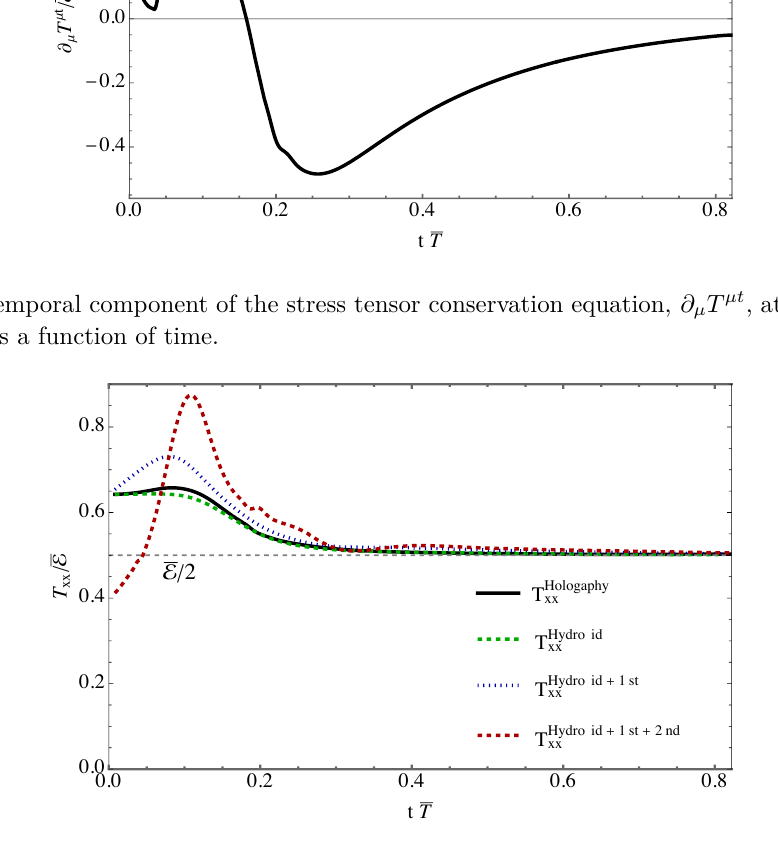
Figure 7 . T xx component of the holographic stress tensor at { x, y } T ’ { 0 . 12 , 0 } as a function of time, solid black line. We include the values of T xx obtained by evaluating the constitutive relations (2.3) up to ideal terms (dashed green), first order terms (dotted blue) and second order terms (dashed